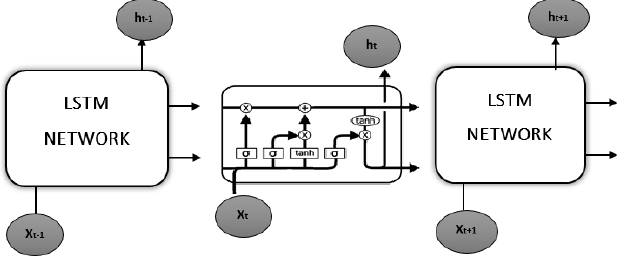
Figure 4. LSTM Network Architecture